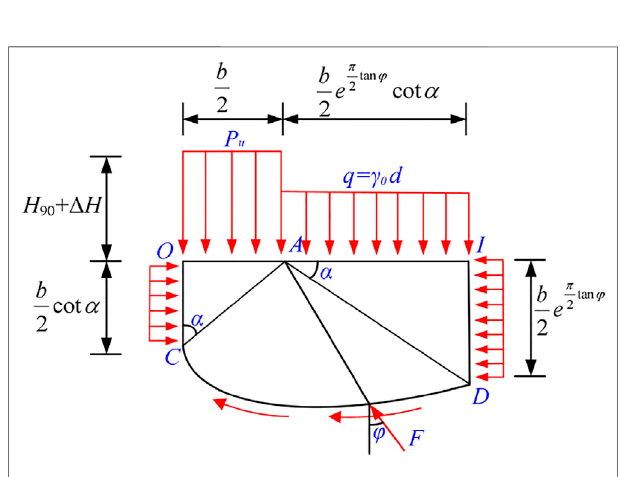
FIGURE 2 | Force analysis of